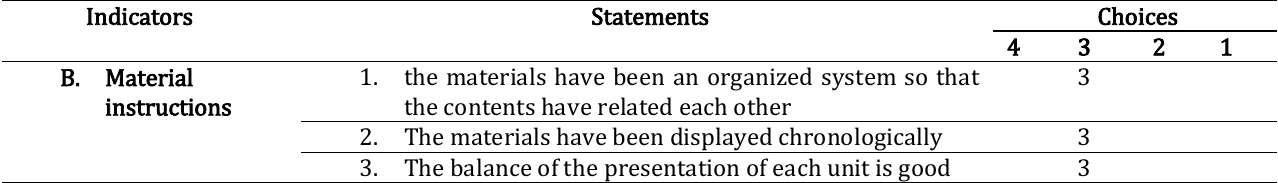
Table 3. The result of validation for appearance aspect of the prototype of teaching materials for Linguistics Description of English subject